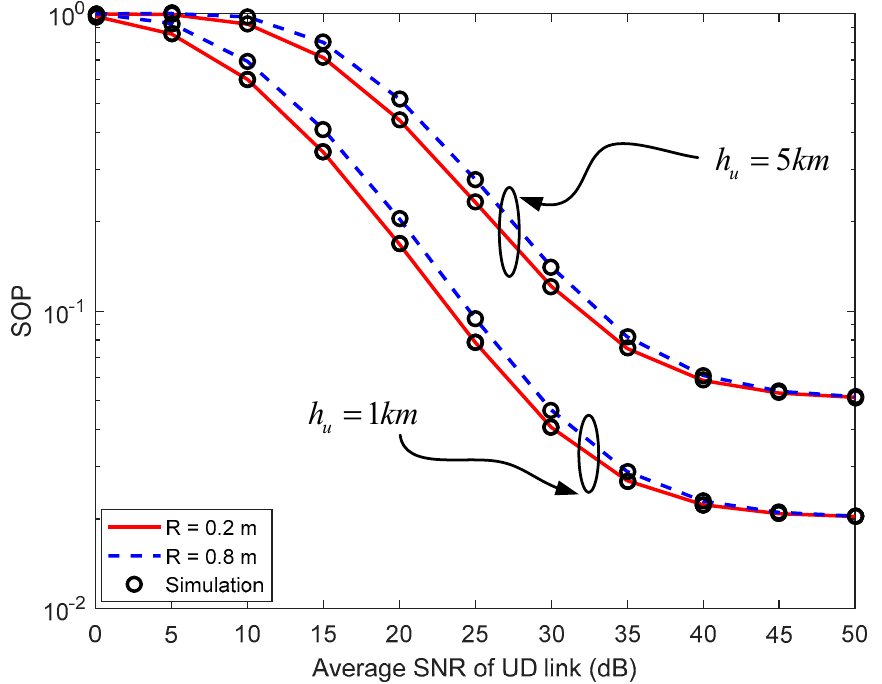
Figure 4. SOP performance under different values of h u and R for γ BU = 25 dB, γ UE = 10 dB, and ρ e = 3 × 10 − 2 .